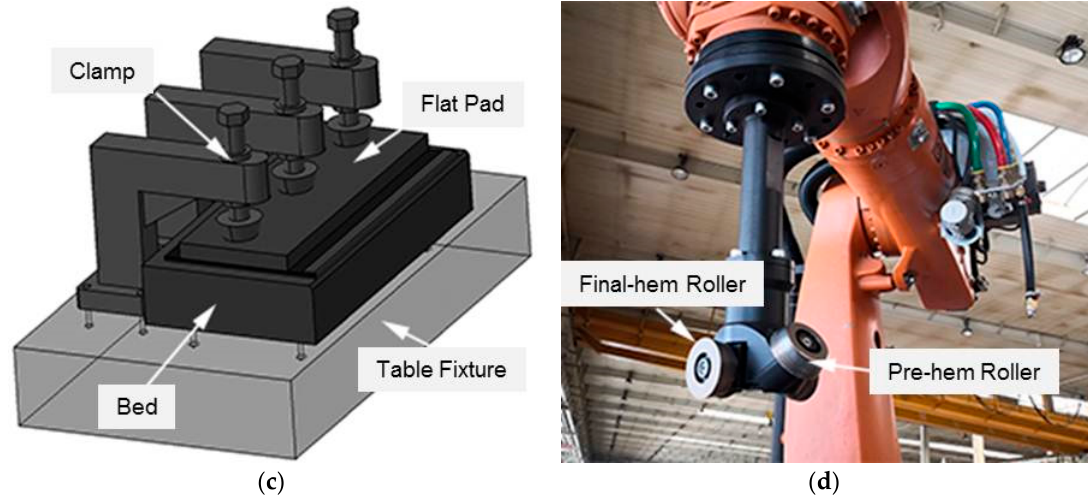
Figure 7. Forming tools for tests: ( a ) flanging die; ( b ) hemming die; ( c ) roller hemming fixture; and ( d ) robot and rollers.